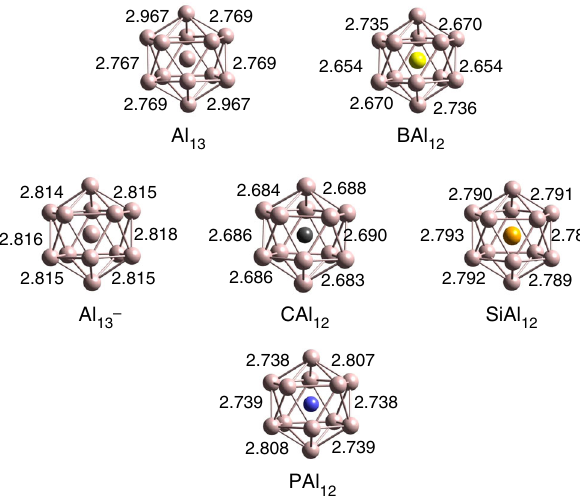
Fig. 1 Ground state structures of Al 13 0/ − and MAl 12 (M = B, C, Si, and P) clusters. The Al – Al bond lengths are also shown and given in Here, we are primarily interested in assessing the effect of shell fi lling on the electronic properties. Therefore, the adiabatic